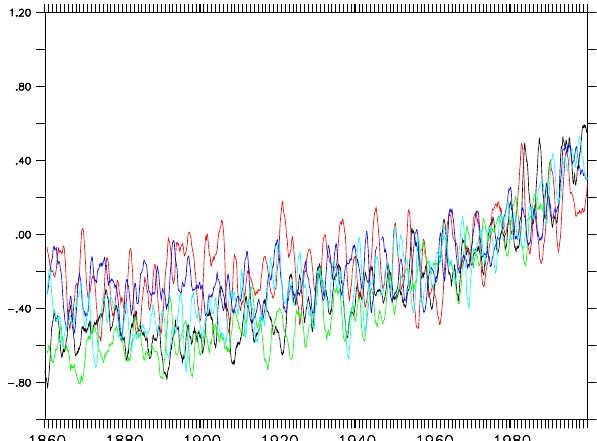
Fig. 7. Global surface temperature anomaly with respect to the 1960–1990 average in K. The lines represent a yearly running mean from simulation TRANS (black) and other IPCC AR4 models (20th century simulations; red: ECHAM5/MPIOM, green: INGV-SXG, blue: UKMO-HadCM3, light blue: